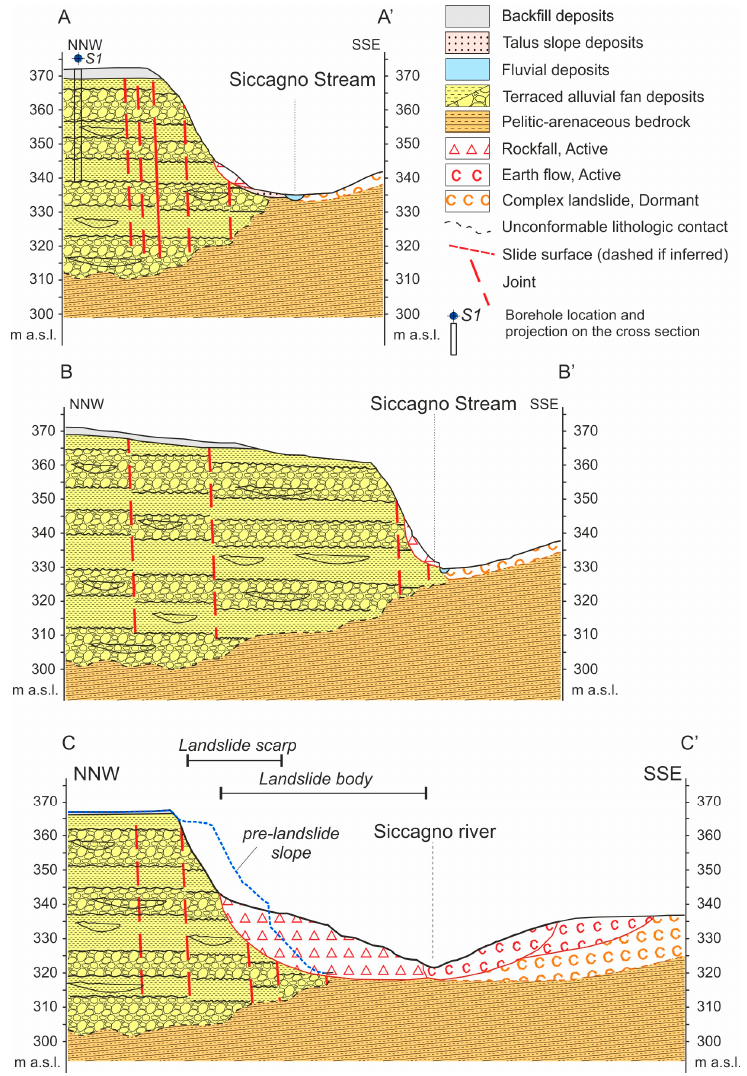
Figure 16. Geological and geomorphological cross-sections of the Southern slope of the Castelnuovo area (location in Figure 14); in Section C-C’ the dashed blue line show the reconstructed pre-landslide topography (cfr. Figure 17).